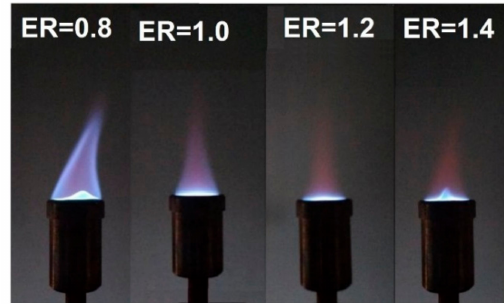
Figure 2. Methane flame at different equivalence ratio (ER) values.